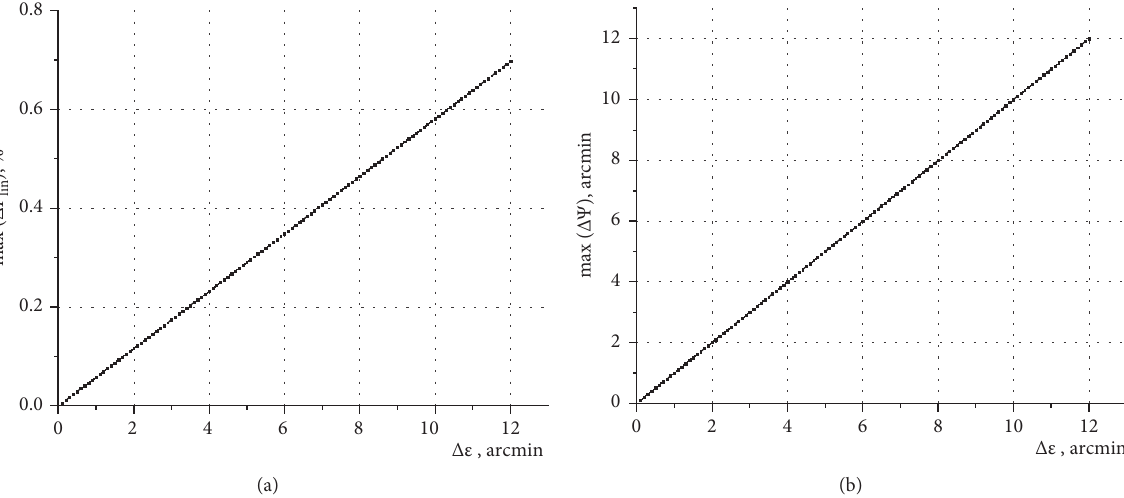
Figure 13: Dependence of the maximum error of determination of the degree of linear polarization P